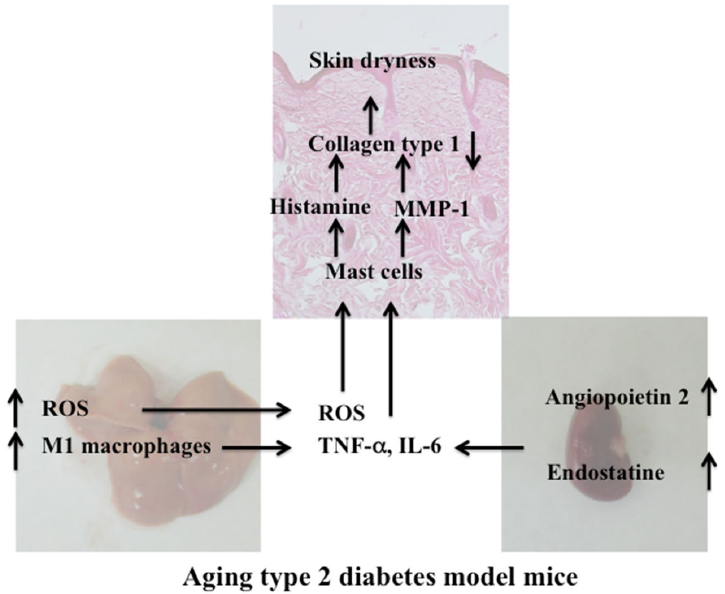
Figure 8. Skin/liver/kidney interactions that contribute to dry skin in aging KK ‐ Ay/TaJcl